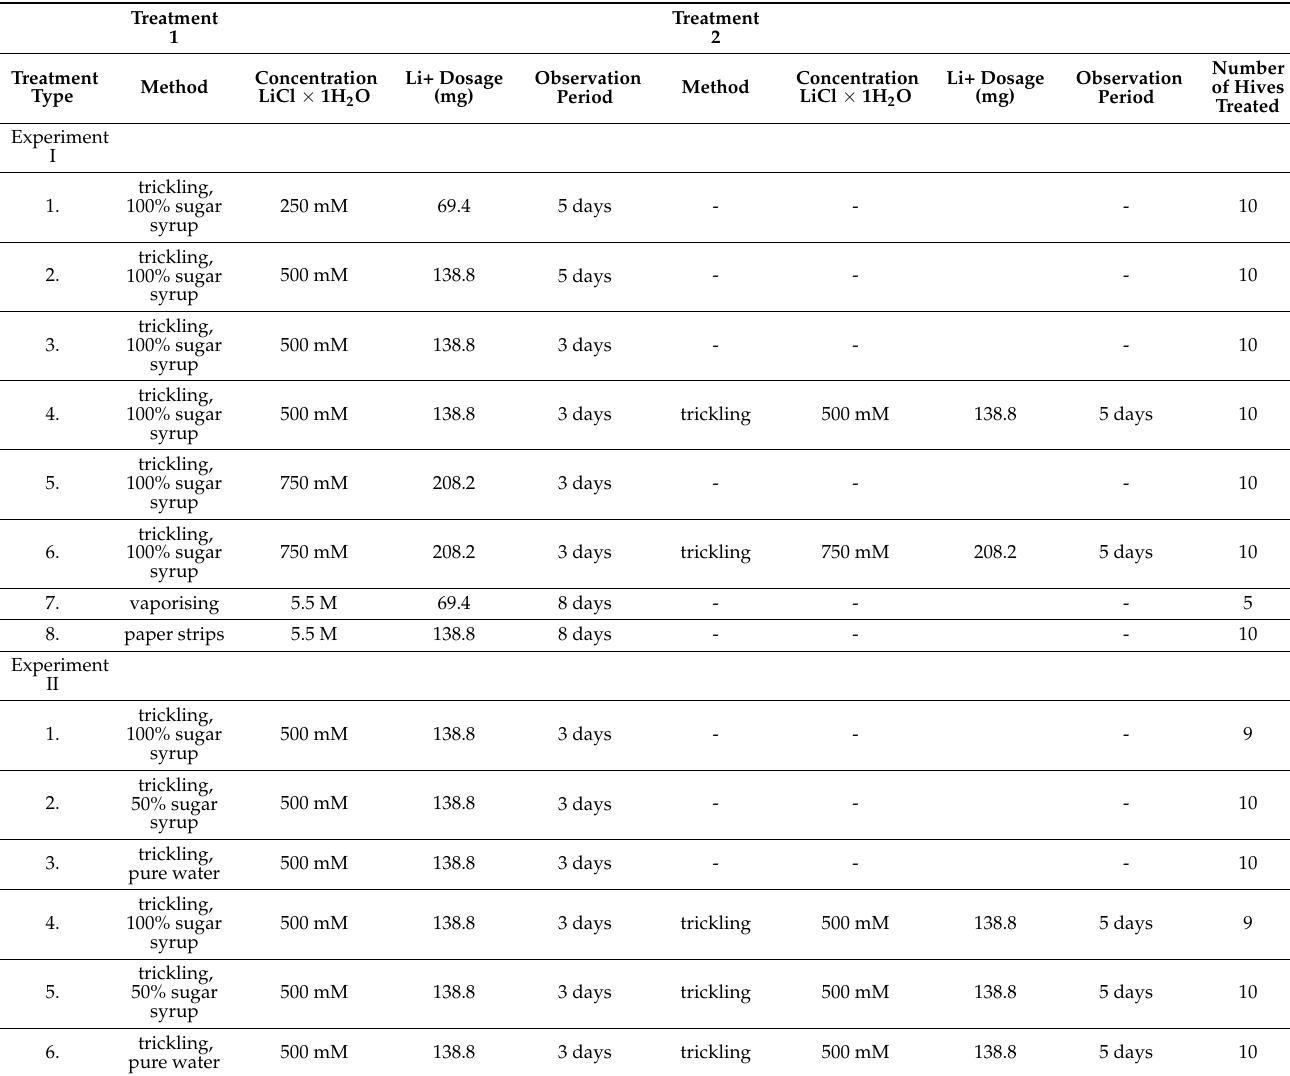
Table 1. Specifications of the tested anti- Varroa LiCl treatment